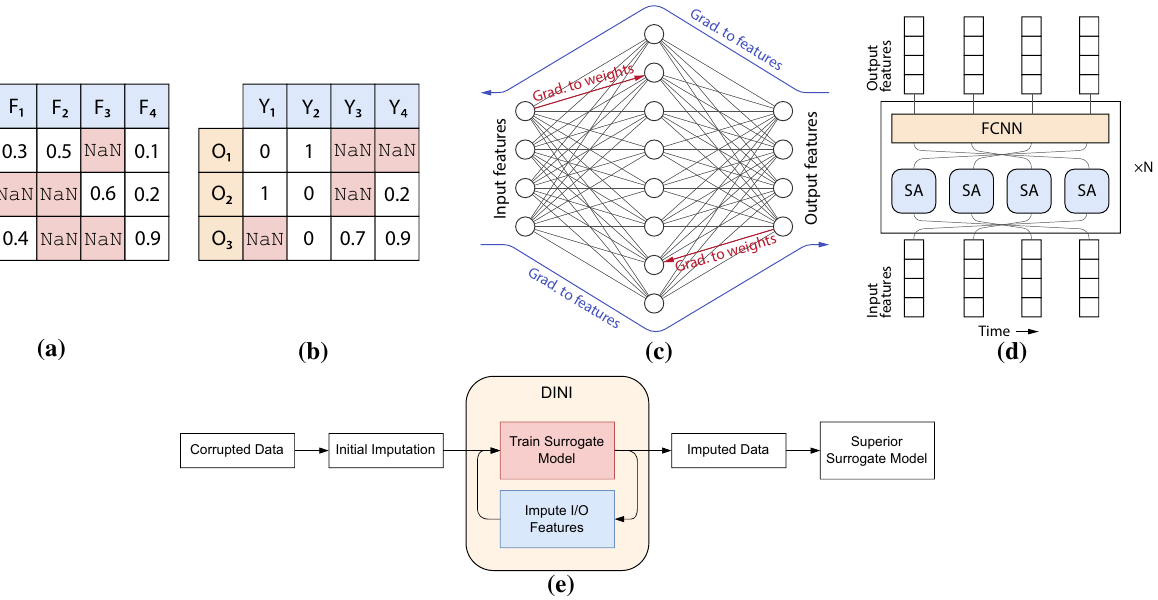
Figure 1. DNN-based data imputation and surrogate modeling framework of DINI. Example ( a ) input and ( b ) output tabular data. Supported surrogate models: ( c ) FCNN-based and ( d ) Transformer-based for time-series data. ( e ) High-level schematic of the DINI